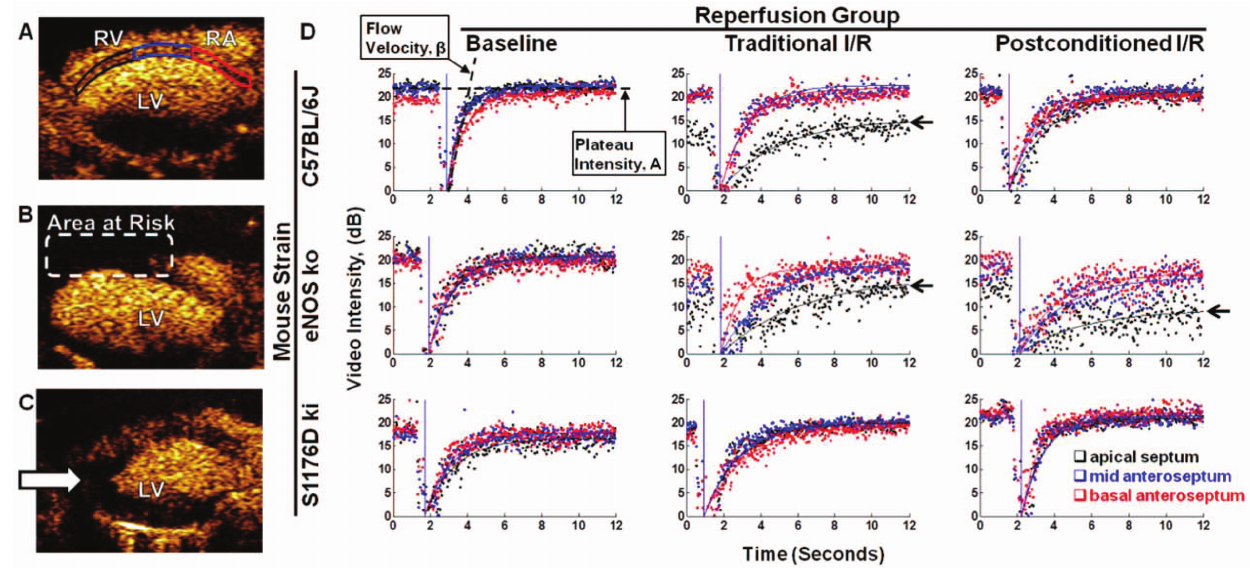
Figure 3. MCE of regional blood flow following I/R. A. The left ventricular septum in the parasternal long axis view was divided into three regions of interest: apical septum (black), mid septum (blue) and basal septum (red). RV: Right ventricle, RA: Right atrium, LV: Left ventricle. Representative MCE image taken at baseline, B. Representative MCE image during ischemia. C. Representative MCE image 30 minutes after reperfusion. D. Analysis of regional change in myocardial perfusion. Representative region-specific replenishment curves 30 minutes post-reperfusion are shown: apical septum (black), mid septum (blue), and basal septal regions (red). Replenishment curves are characterized by the myocardial blood flow parameters A (plateau intensity) and b (flow velocity).